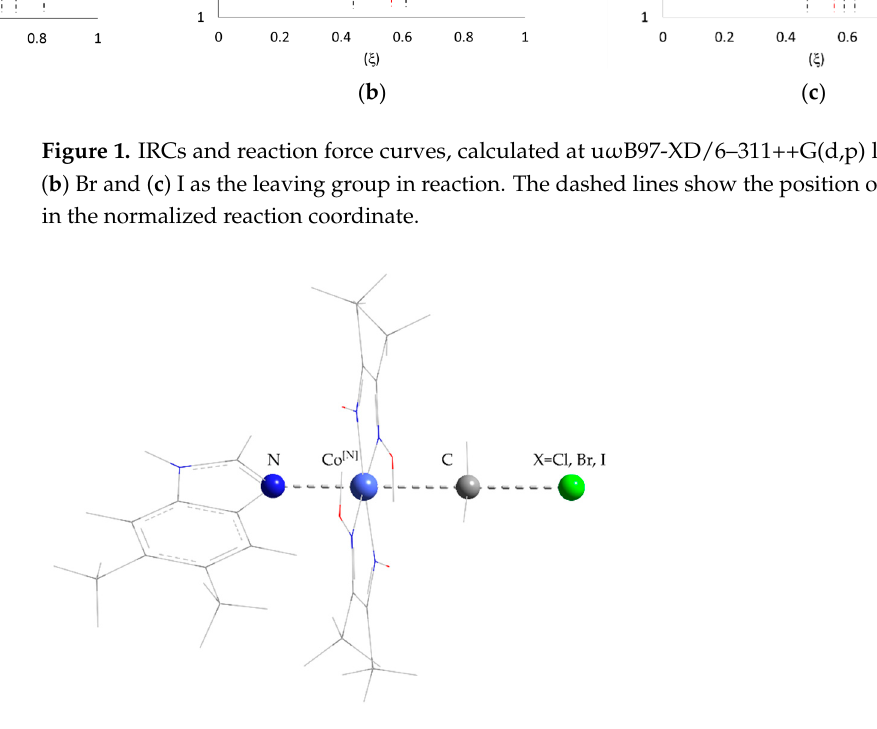
Figure 2. Graphical representation of the transition state Co[N]Cbx ··· CH 3 ··· X (X = Cl, Br, I) empha- sizing the relevant bonds. Table 1. RF works, activation ( ∆E (cid:2999) ), and reaction ( ∆ E 0 ) energies in kcal/mol, calculated at the u ω B97- XD/6–311++G(d,p) level and obtained from the IRC profiles.